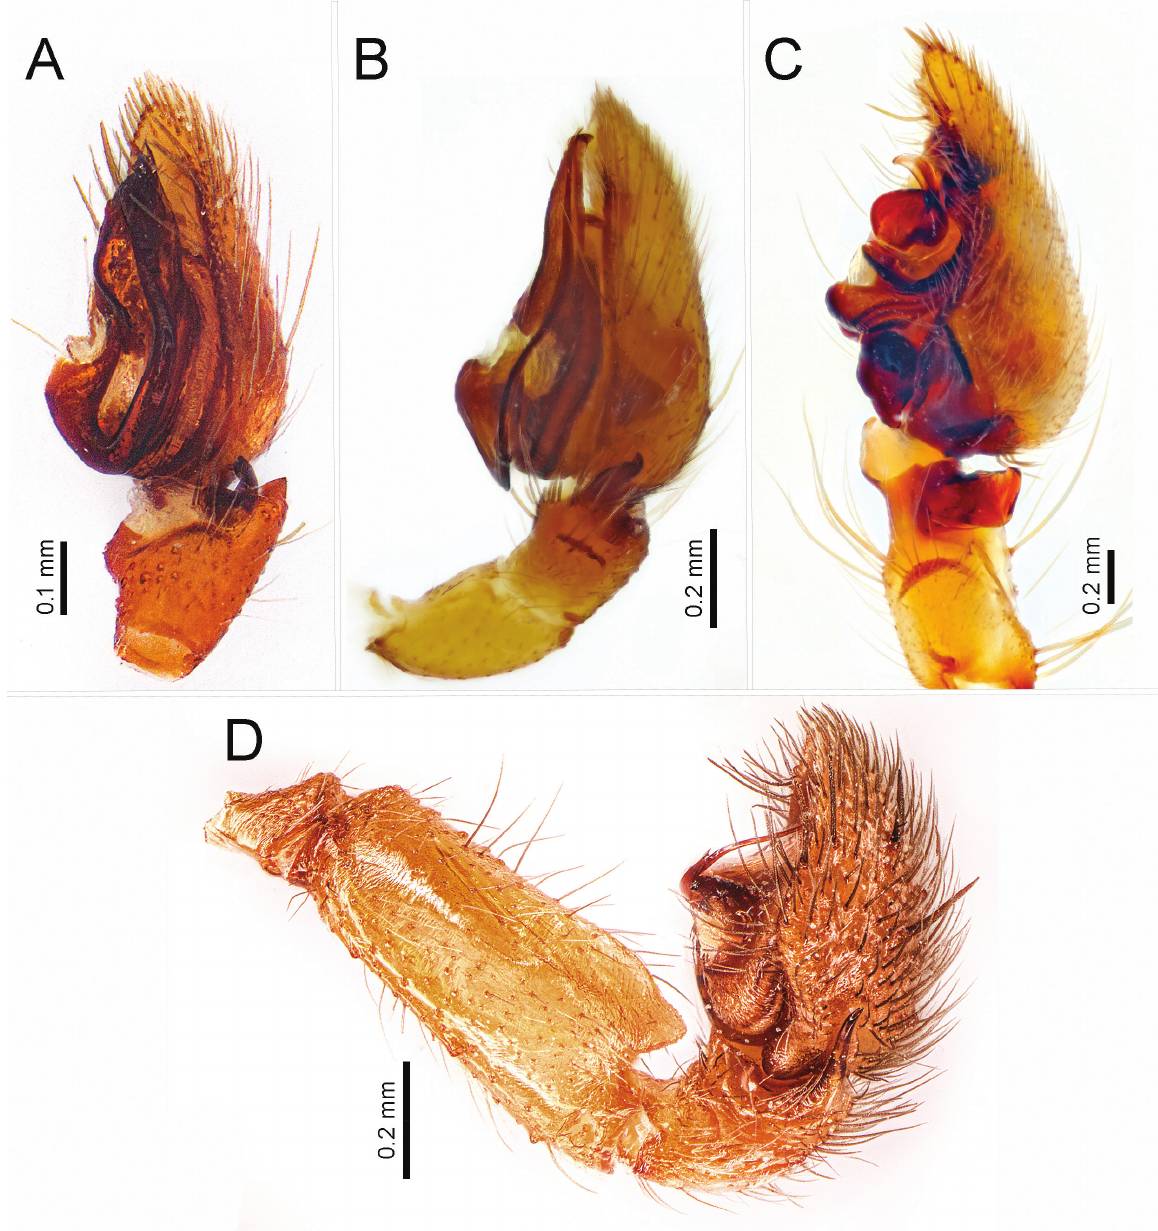
Figure 3. Male palps of gnaphosids, retrolateral view. A. Odontodrassus aravaensis Levy, 1999; B. Odontodrassus mundulus